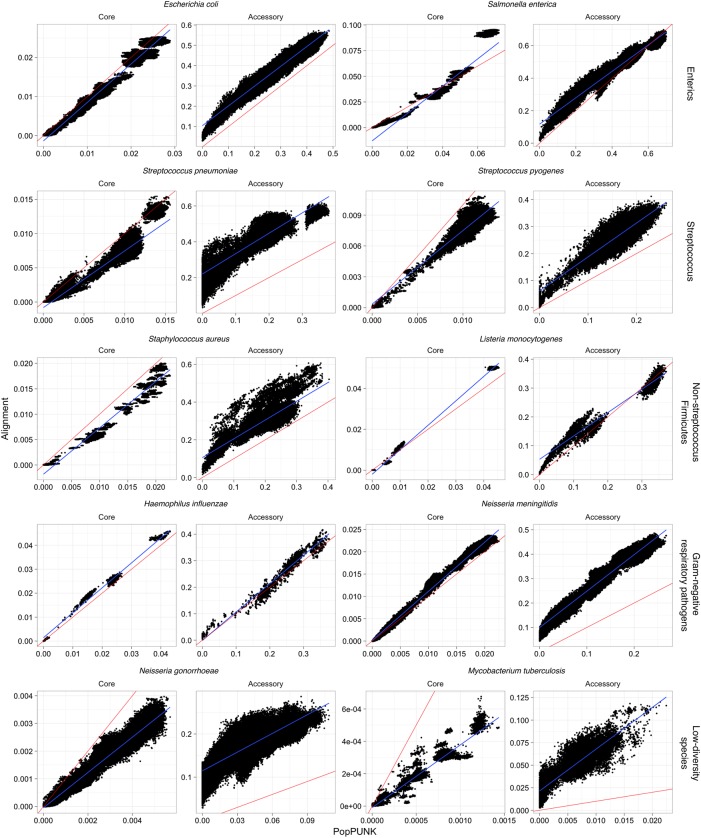
Comparison of core and accessory distances from PopPUNK (x-axis) and pan-genome construction with Roary (y-axis). For each species, the core distance was calculated as the Tamura-Nei (tn93) distance from the core genome alignment; the accessory distance was calculated as the Jaccard distance between binary strings representing gene presence/absence. In each panel, the line of identity (red line) and a linear regression (blue line) are also plotted. Sketch sizes were 104, except for M. tuberculosis which used a sketch size of 105.